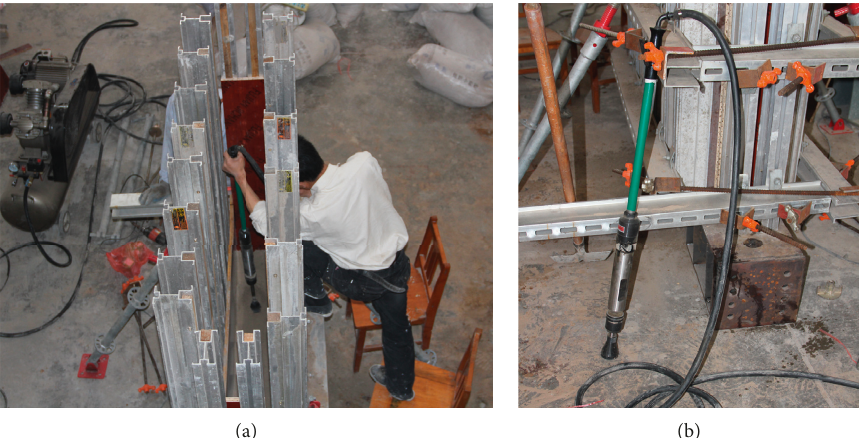
Figure 3: Moulds and pneumatic rammer used for specimen construction. (a) Supports and moulds. (b) D9 pneumatic rammer.